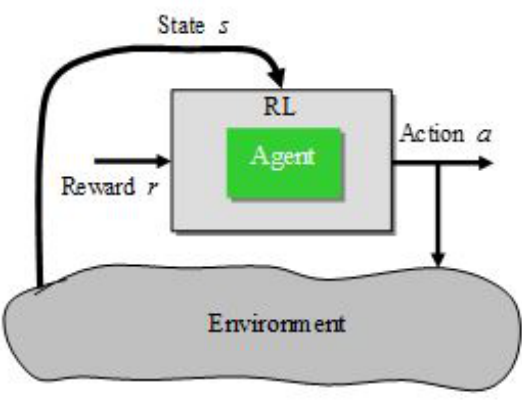
Figure 6: Framework of standard reinforcement learning